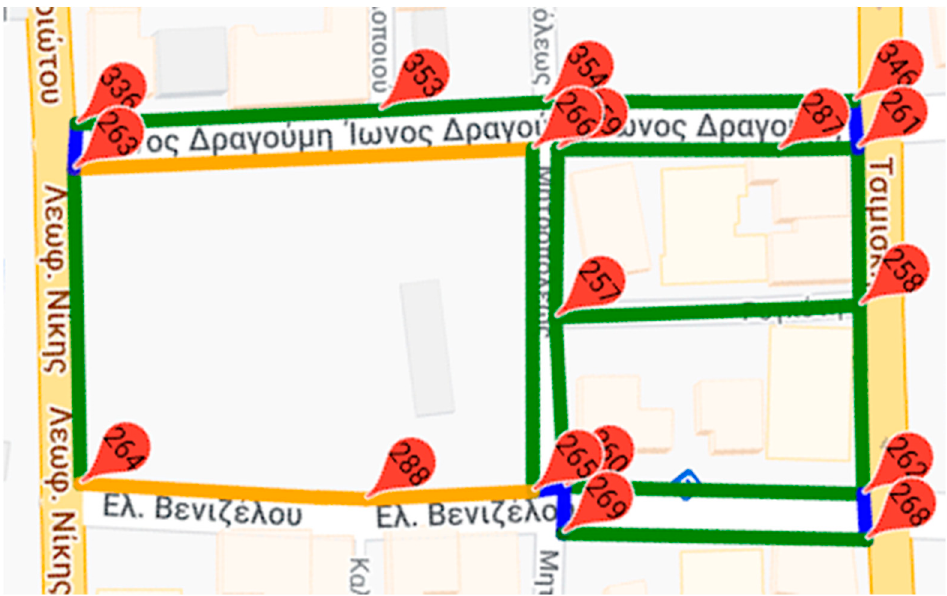
Figure 3. Use case II graph dataset. Table 2. k-shortest paths for use case II.